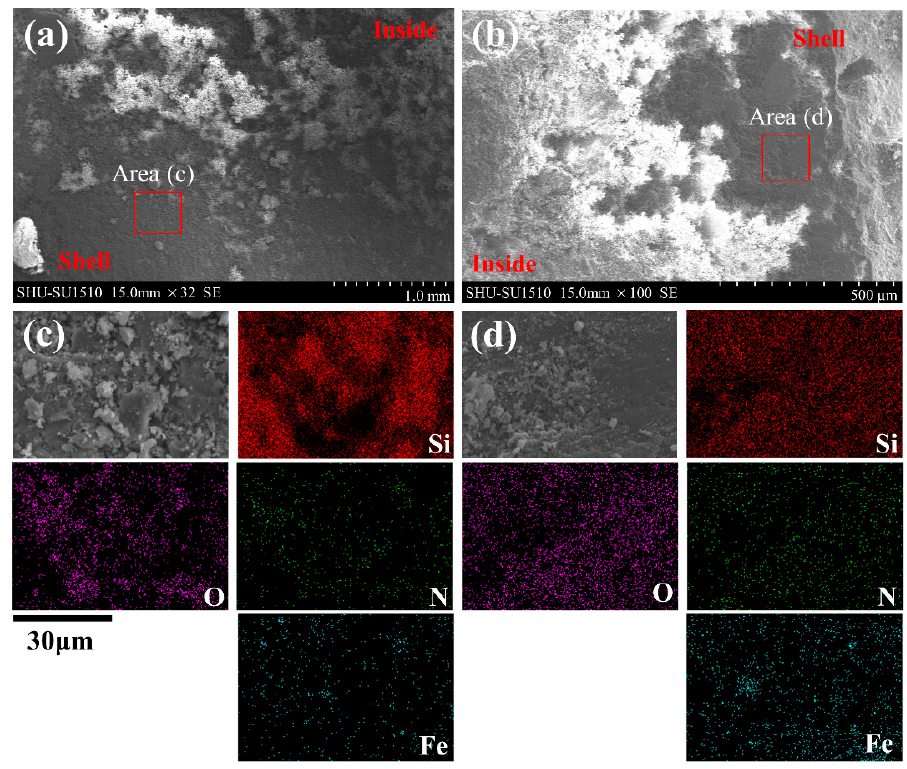
Figure 9. SEM of the cross section of Si and Si 3 N 4 briquette: ( a ) Si briquette, ( b ) Si 3 N 4 briquette; EDS image of outer shell: ( c ) Si briquette, ( d ) Si 3 N 4 briquette.